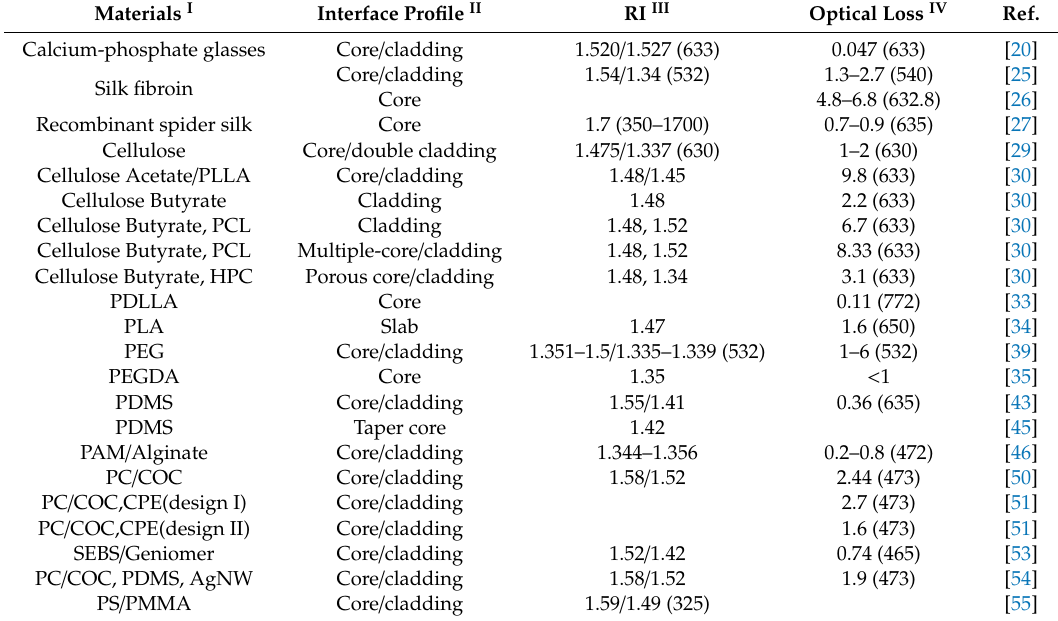
Table 1. The optical loss and RI of virous optical waveguides.